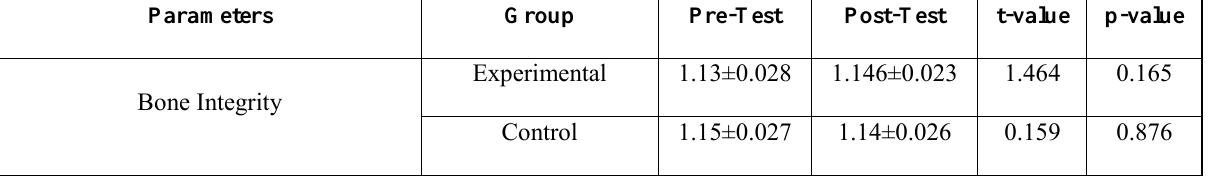
Fig. 3. Mean values of Metabolic Fitness (MetF) (i.e., Maximal Oxygen Consumption (V O2 max), Blood Lipid and Blood Sugar) in Experimental and Control group (n=15 each) before (Pre) and after (Post) 4-weeks Bhastrika Pranayama Training Programme (Experimental group only). Mean values (±SD) and Paired Sample t-test of Bone Integrity in Experimental and Control group (n=15 each)